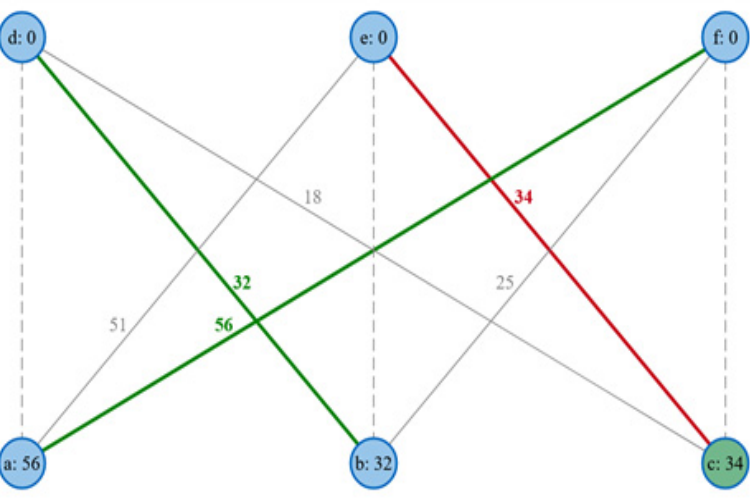
Figure 5. Similarity graph (bipartite).